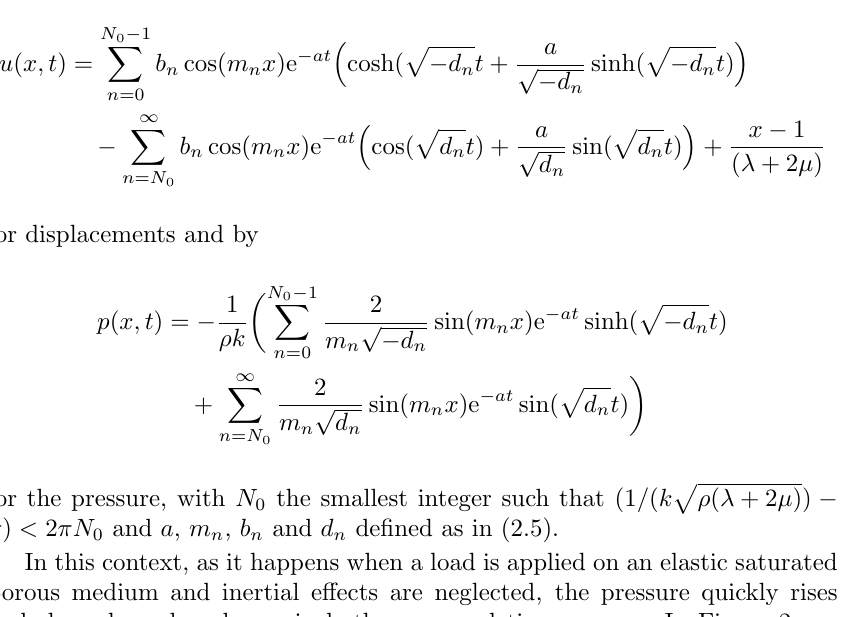
(cid:112) If kπ ρ ( λ + 2 µ ) − 1 = 0 we are in a transition case, however from